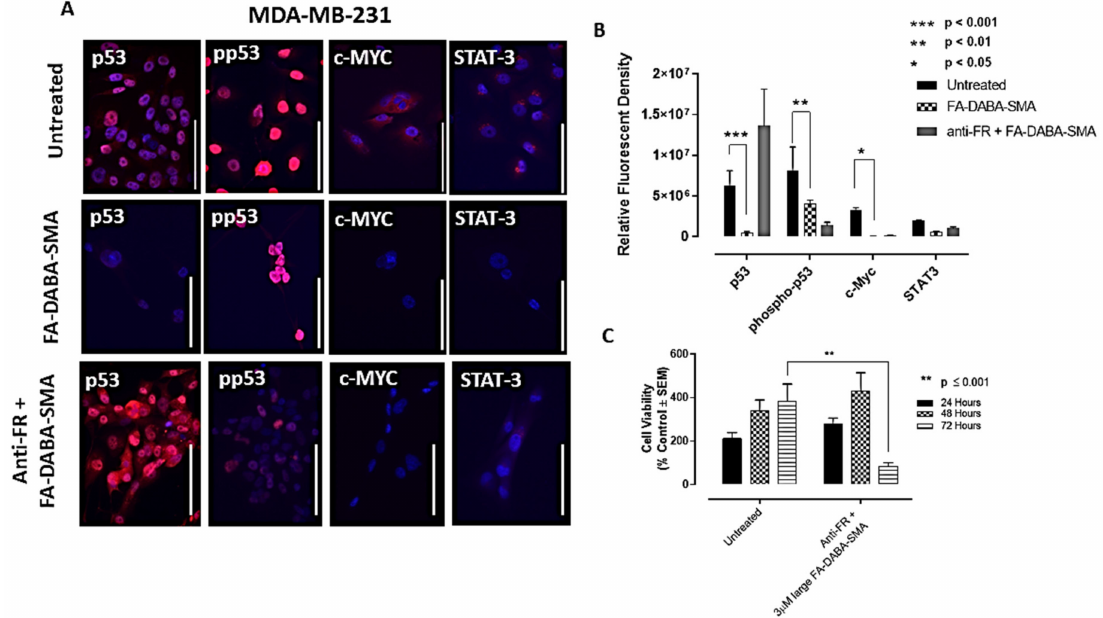
Figure 6. Dual role of FA-DABA-SMA copolymer targeting folic acid receptors (FR) and intracellular Inhibition of STAT3, p53 and c-Myc in MDA-MB-231 breast cancer cells. ( A ) Immunocytochemistry staining of p53, phosphor-53, c-Myc and STAT3 on the MDA-MB-231 cell line before (untreated), treated with large 350 kDa FA-DABA-SMA copolymer or pretreatment with an anti-FR antibody for two hours followed by large 350 kDa FA-DABA-SMA nanopolymer. The white scale bar represents 100 µ m taken at 400 × magnification. Blue DAPI stain represents the nuclei, and red staining is a primary antibody for the respective protein expression followed by AlexaFluor 594 secondary antibody. ( B ) Quantification of expression levels by relative density corrected for average background staining of the secondary antibody, mean ± S.E.M. of three to four di ff erent staining images. Results were compared by a one-way ANOVA at 95% confidence using Fisher’s LSD test for a combination of two independent experiments. ( C ) Comparison of the cell viability of MDA-MB-231 cells’ pretreatment with an anti-FR antibody for two hours followed by large 350 kDa FA-DABA-SMA nanopolymer at 24, 48 and 72 hours using